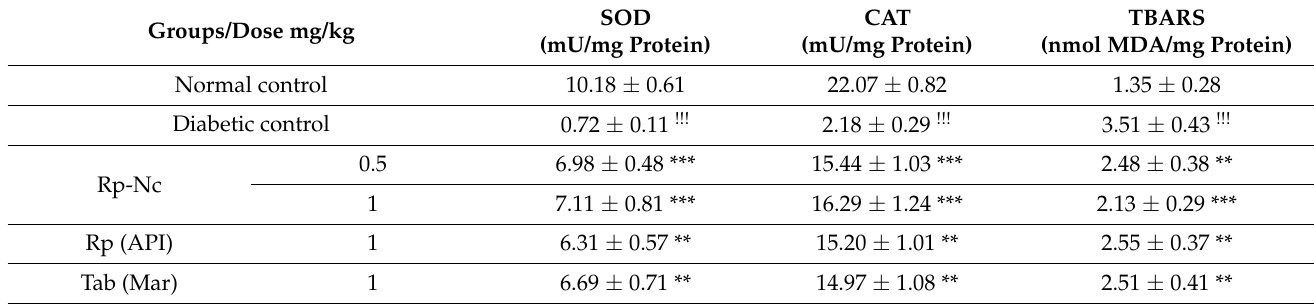
Table 8. Oxidative stress marker and antioxidant enzyme of various experimental groups. Groups/Dose mg/kg